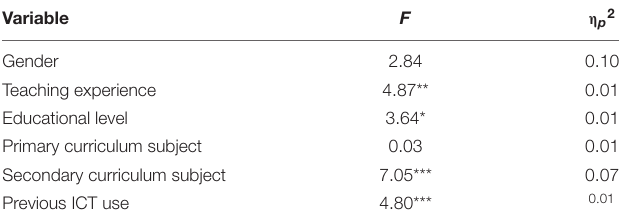
TABLE 4 | Influence of the different variables on the type of activity.